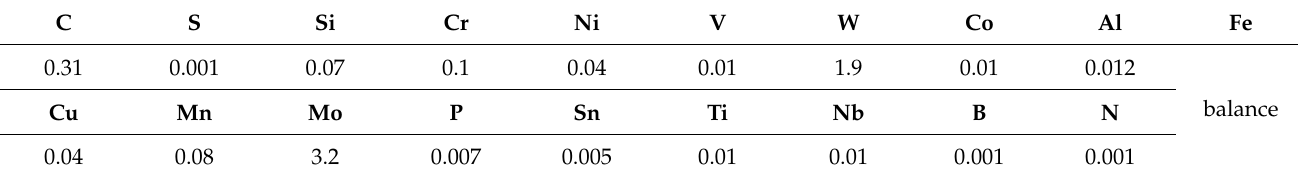
Table 1. Chemical composition of the tested HTCS-130 hot work tool steel (mas.